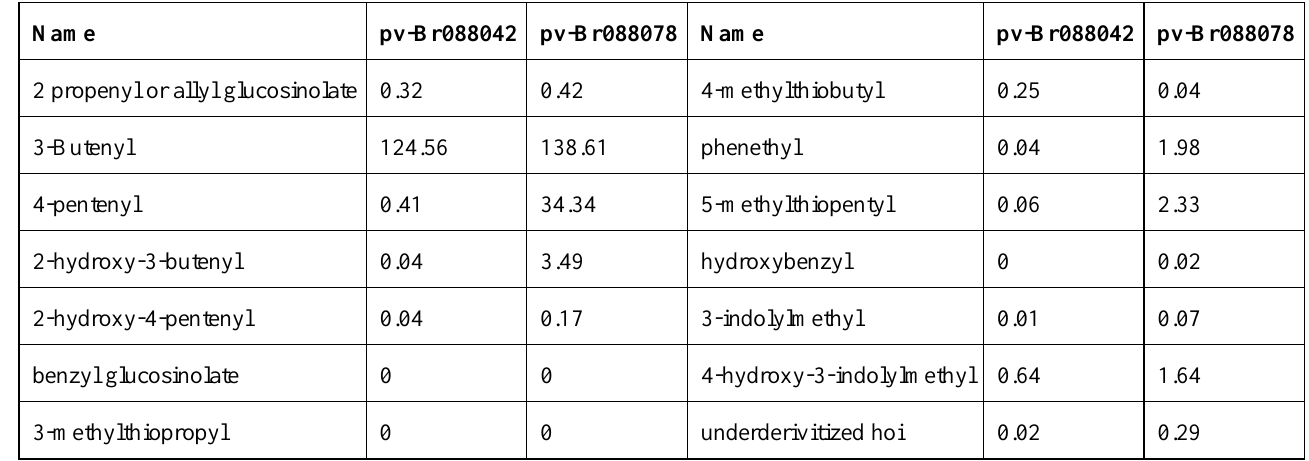
Table S3: 14 targeted metabolites with their intensities in two DH